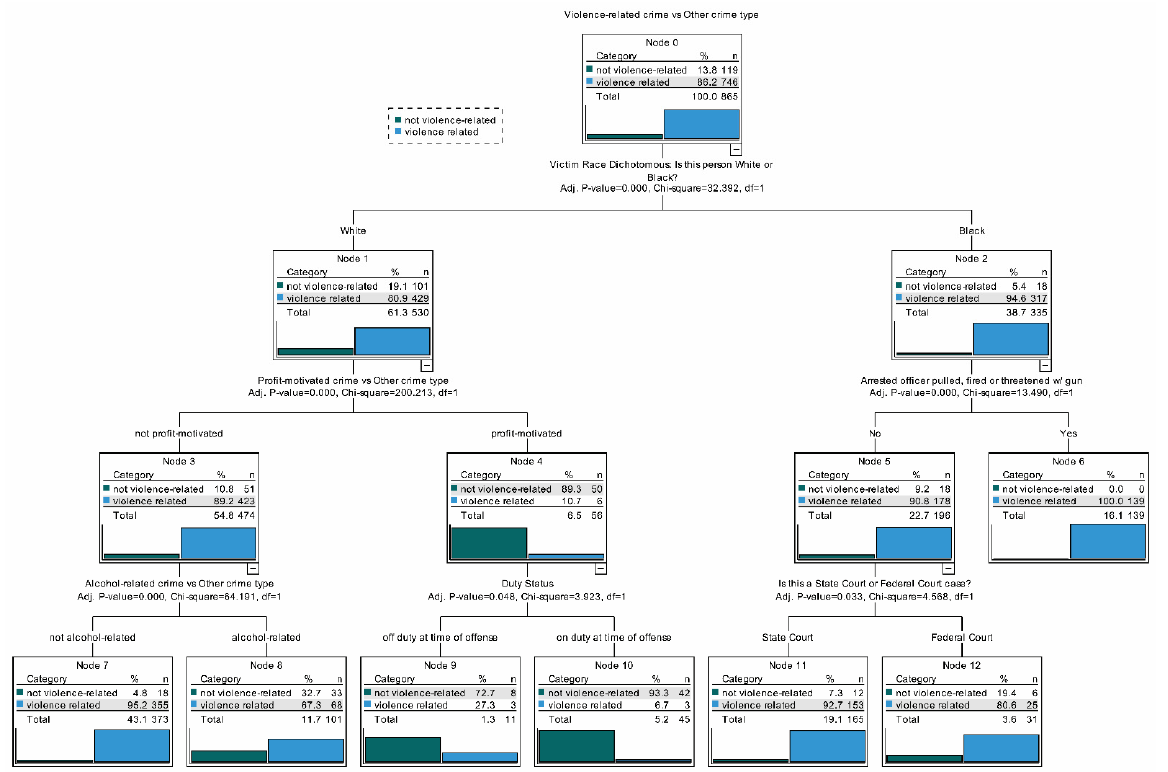
Figure 1. CHAID model predicting violence-related police crime ( N = 865).